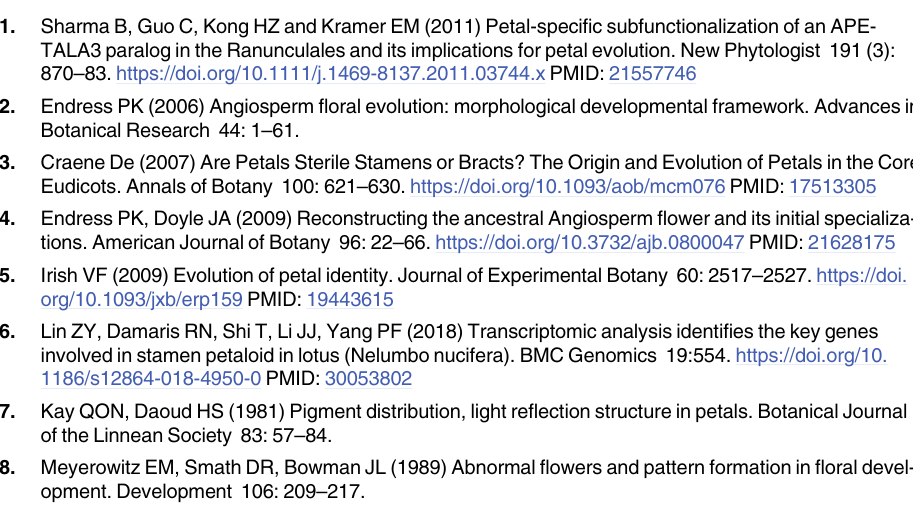
S3 Table. Genes showing significant differential expression between green bracts and white bracts. S4 Table. Pathway of genes showing differential expression between green bracts and white bracts. S5 Table. Putative identifications of S . chinensis genes, and their transcript abundance lev- els in white and green portions of bracts during the green-to-white transition, at the fully white stage, white and pale green portions of bracts during the white-to-green reversion, and at the fully pale green stage. S6 Table. RT-qPCR